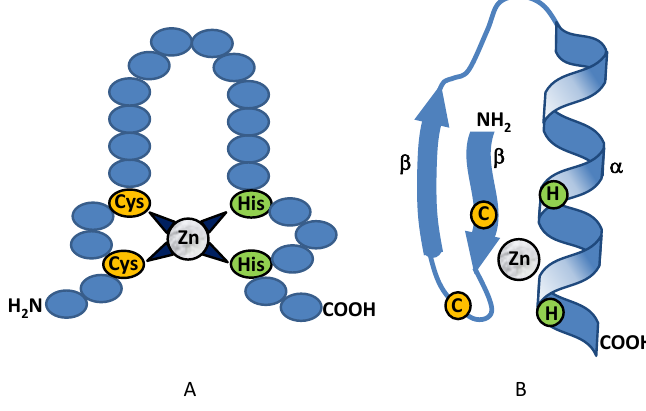
Figure 2. Primary ( A ) and secondary ( B ) structures of the C 2 H 2 domain.